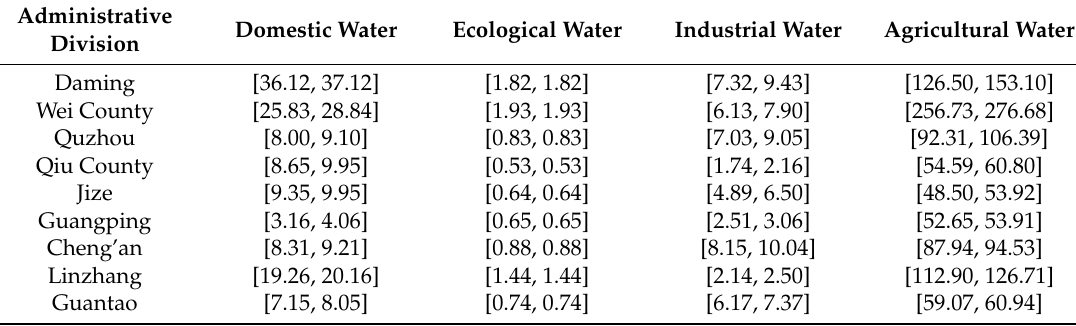
Table 8. Result of water resources allocation to every user (w i = (0.7, 0.2, 0.1)) (10 6 m 3 ).